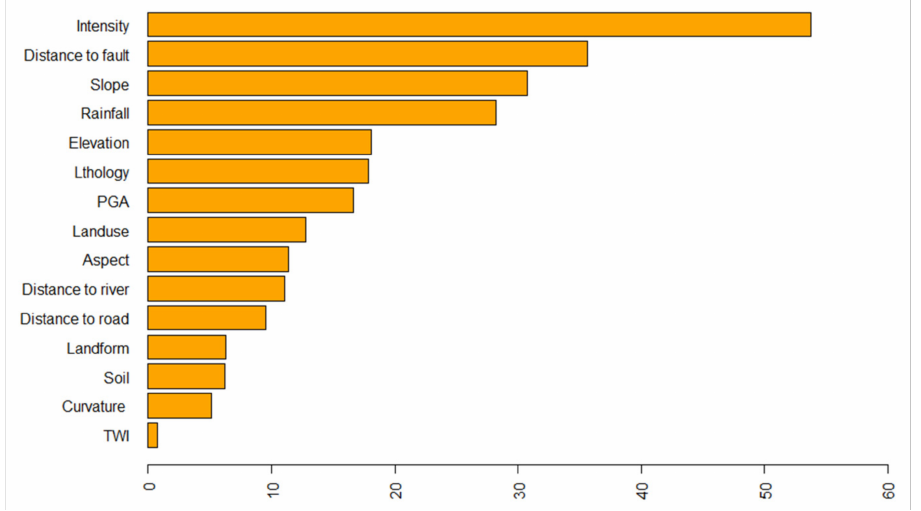
Figure 8. Importance of 15 causative